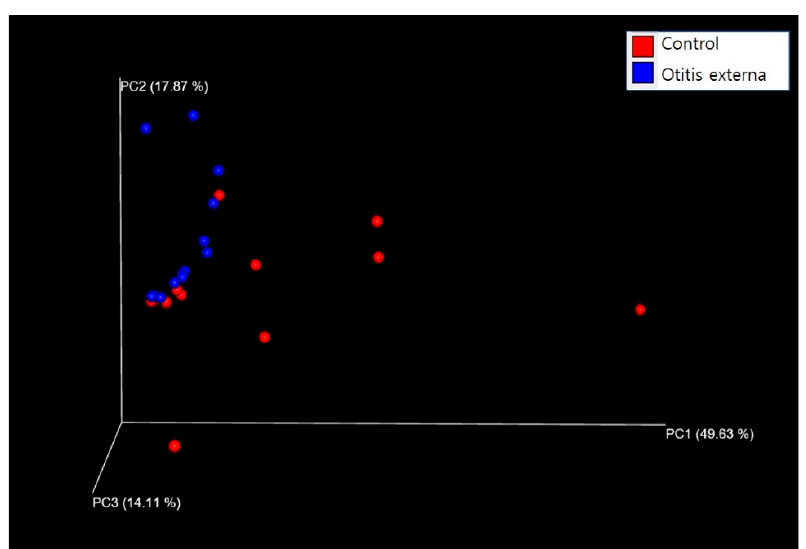
Figure 3. Three-dimensional principal coordinates analysis based on the weighted UniFrac distance matrix. Colored spheres represent samples. The percentages for PCs 1–3 denote the variance ex- plained by each PC. explained by each PC.